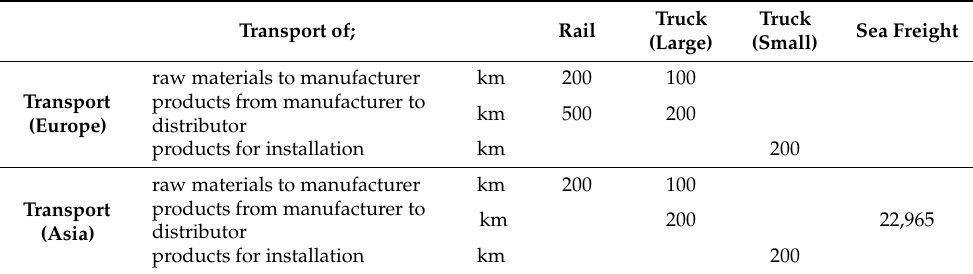
Table 5. Transport assumptions of manufacturing in Europe and Asia [36].